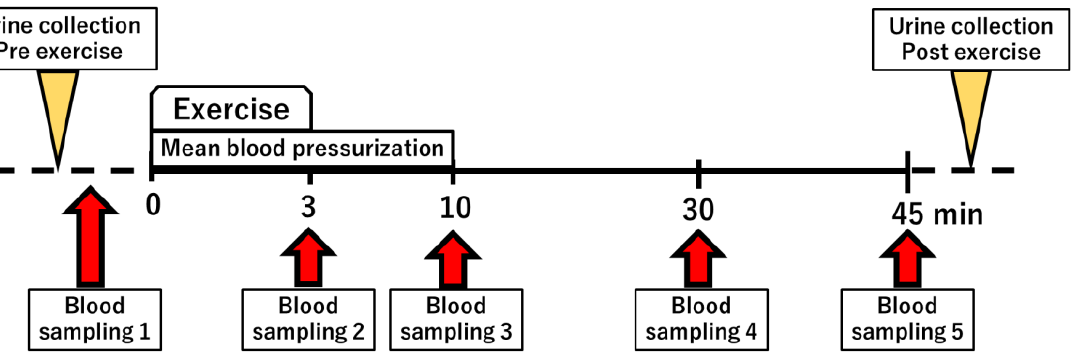
Figure 1. Overview of the semi-ischemic forearm exercise test.